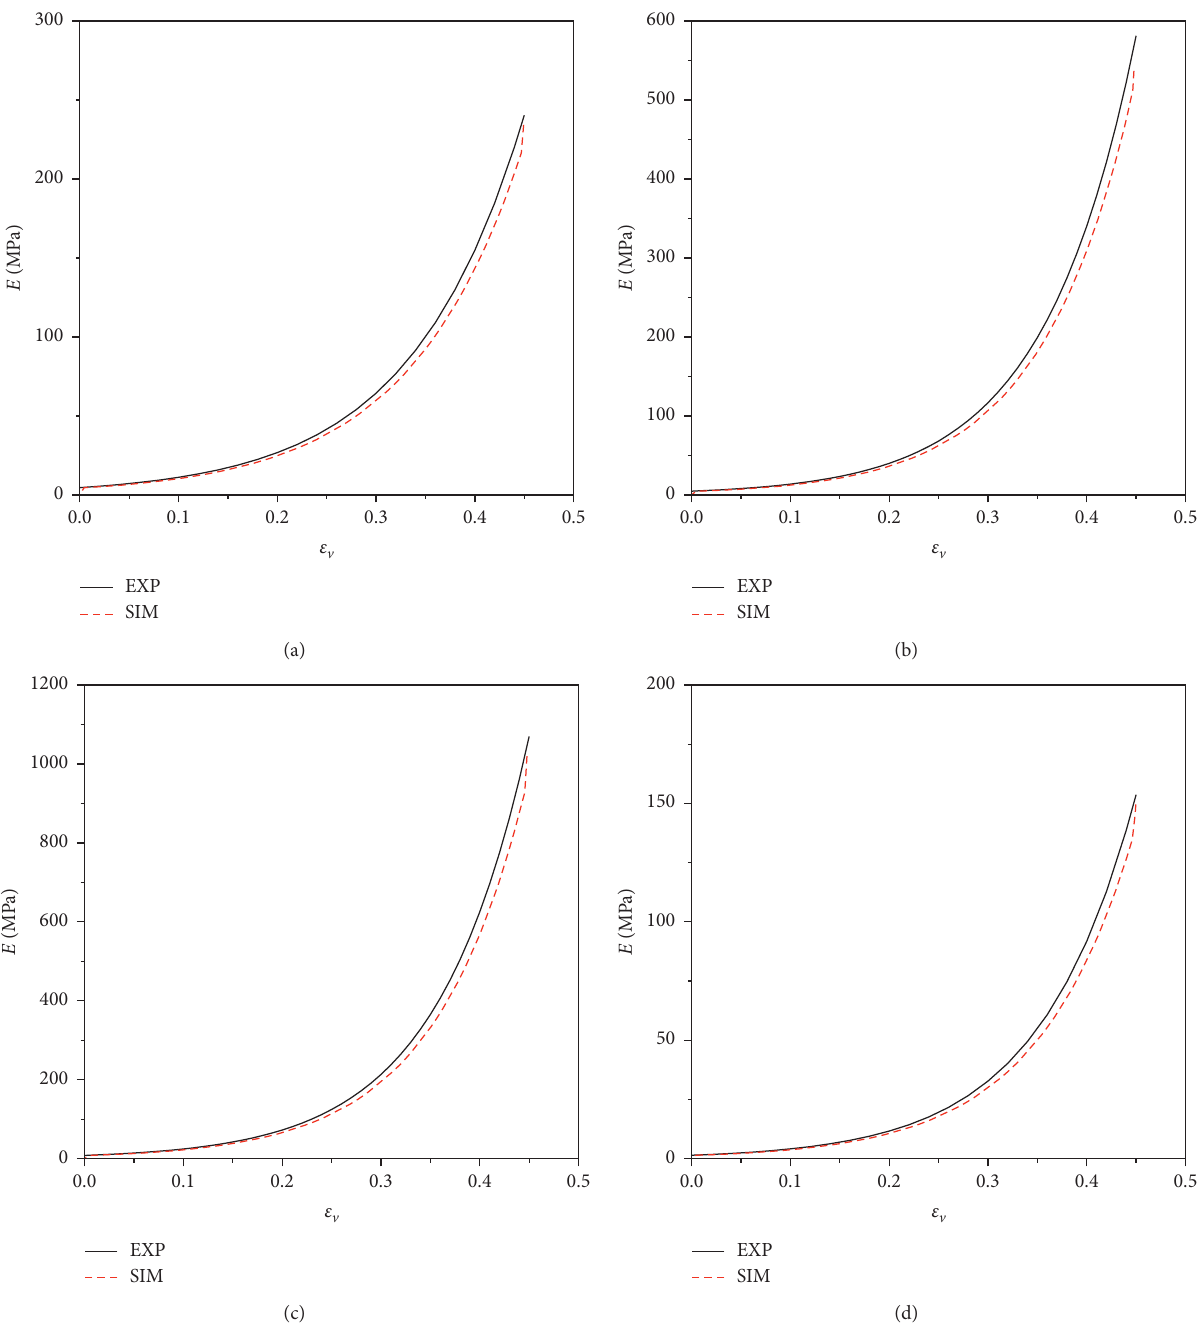
Figure 6: Elastic modulus curves of various broken rocks in experiment and simulation changing with volume strain. (a), (b), (c), and (d) represent broken rock